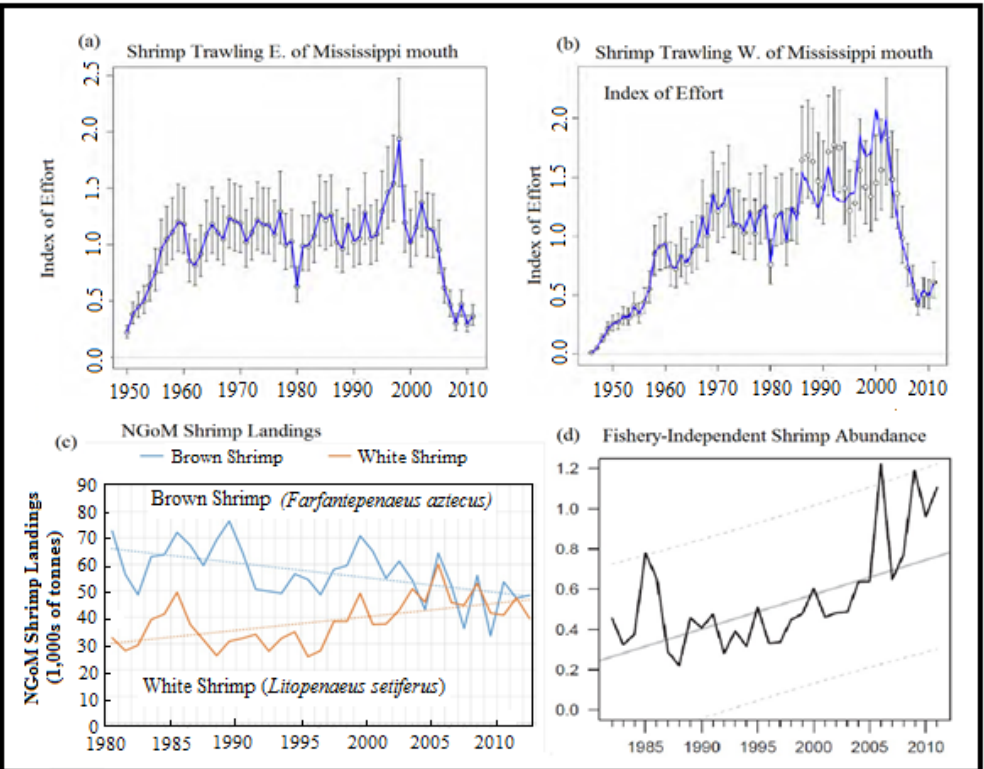
Figure 3. Observed and estimated indices of shrimp trawling effort 1950–2011 ( A ) east and ( B ) west of the Mississippi birdsfoot delta; ( C ) 1981–2013 landings data for white and brown shrimp and ( D